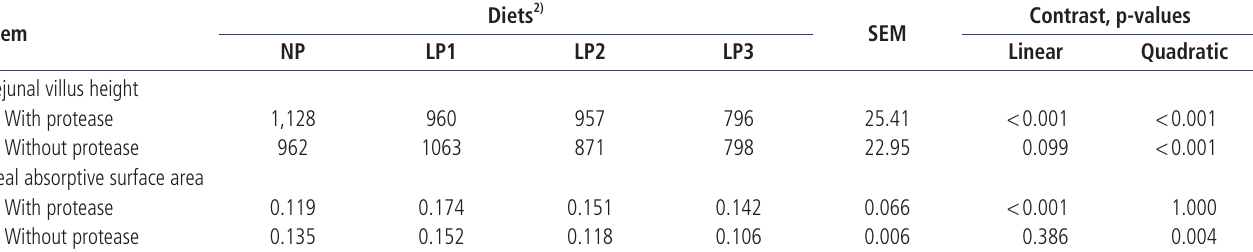
SEM, standard error of mean. 1) Data represent mean value of 8